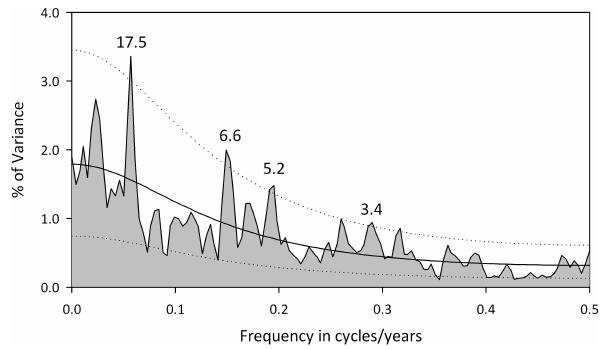
Fig. 6. Blackman-Tukey spectral density of the reconstructed Neuqu´en River streamflow (1346–2000). The dotted lines represent the 95% confidence interval and the dashed line is the red noise